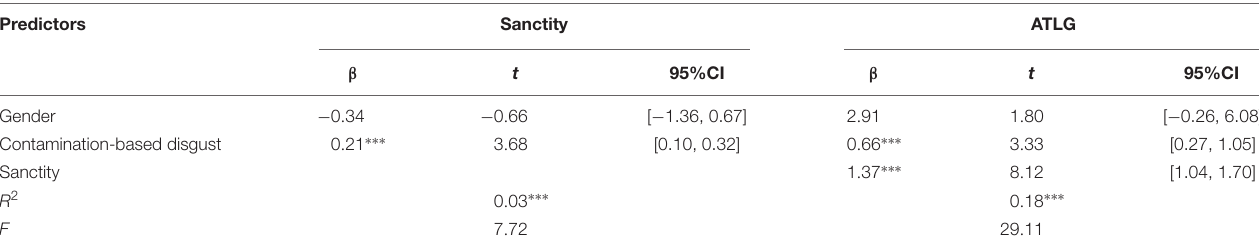
TABLE 6 | Individual associations between variables in the mediation model, where sanctity was hypothesized to mediate the association between contamination-based disgust and ATLG ( N = 452). Predictors